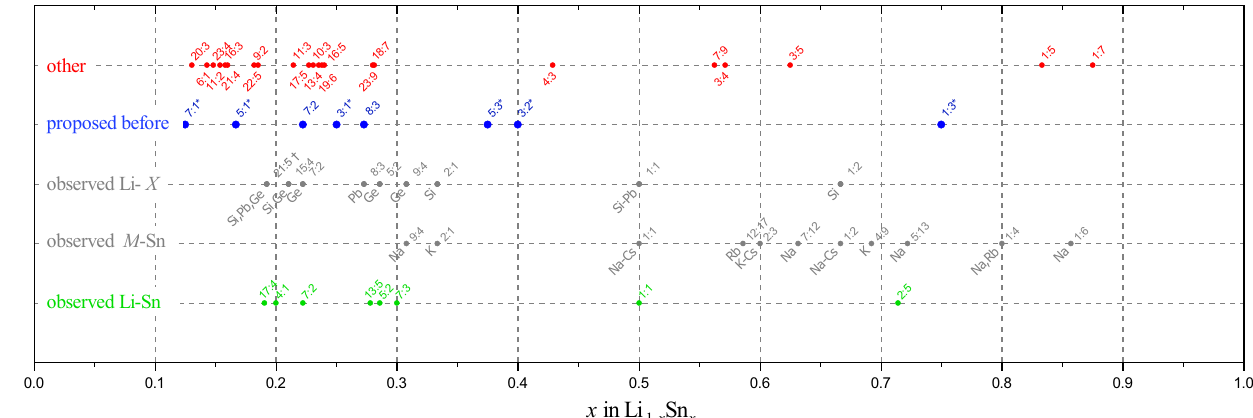
Fig. 1 Relevant compositions in the Li-Sn system explored with our NN-based evolutionary searches. The bottom green set denotes experimentally observed Li-Sn compounds 116 . The two gray groups specify stoichiometries observed in related M -Sn and Li- X binaries 116 . The blue set refers to thermodynamically stable compounds predicted in previous studies 47,50 for 0 GPa and 20 GPa (the latter are marked with asterisks). The top red group corresponds to additional compositions considered in this study: all possible m : n ratios with ( m + n ) ≤ 8 and a few larger subsets with m = 6 – 23 and n = 1 – 9 near regions with known stable